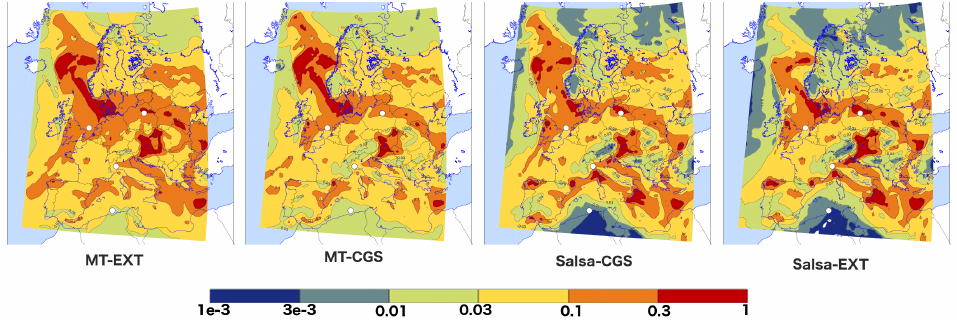
Figure 4. Aerosol optical depth over Europe on 22 December 2007, 12:00UTC (noon). Results are shown for the mass transport model in conjunction with the old external-mixture optics model (first to the left), and with the new internal-mixture/core-grey-shell/fractal BC aggregate model (second to the left), as well as for the MATCH-SALSA model in conjunction with the new optics model (third to the left) and old optics model (fourth to the left). The circles indicate the four locations used for radiative transfer studies. Note the semi-logarithmic colour scale! Table 4. Averaged relative difference in aerosol optical depth (AOD), backscattering coefficient (BSCA), single scattering albedo (SSA) and asymmetry parameter ( g ), among the different model set-ups for December 2007. The average has been performed over a whole month and over all grid cells (horizontally for AOD, horizontally and vertically for all other optical properties). Each number corresponds to a relative difference between two model set-ups. For instance, MT(EXT,CGS) = (MT-EXT − MT-CGS) / (MT-CGS) compares results obtained with the mass transport model (MT) by using the two different optics models (EXT and CGS). X λ (nm) MT(EXT,CGS) SALSA(EXT,CGS) CGS(MT,SALSA) EXT(MT,SALSA) AOD 355 0.16 − 0.28 − 0.50 − 0.19 AOD 532 0.08 − 0.14 0.00 0.25 AOD 1064 0.18 0.37 0.44 −